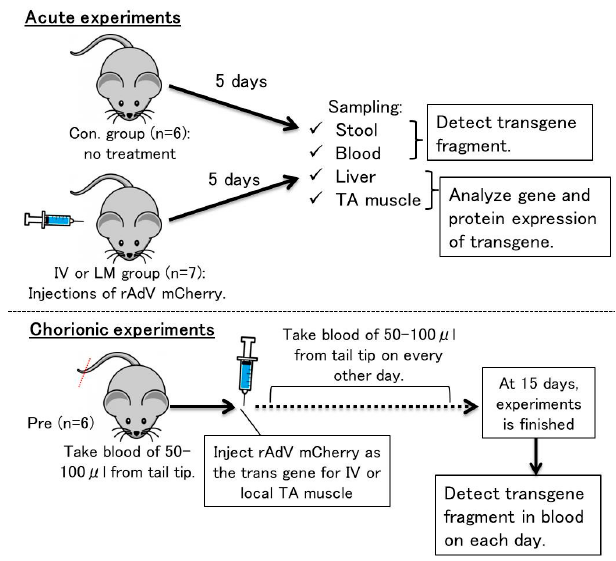
Figure 1. Overview of animal experiments carried out in this study.